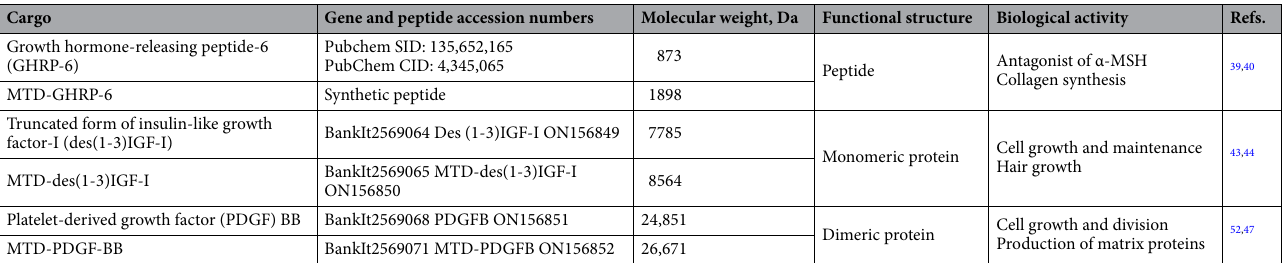
Table 1. Characteristics of the cargoes selected for MTD